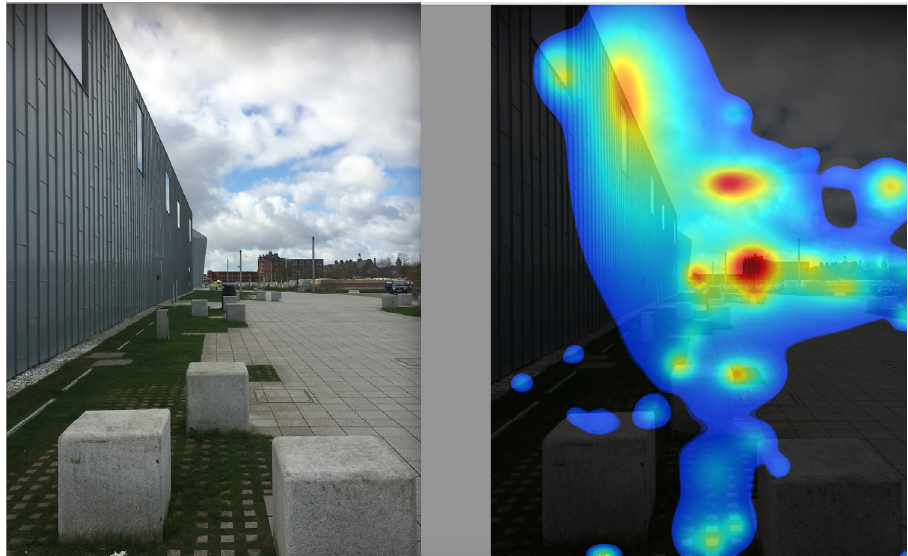
Figure 14. RSM side wall with concrete bollards/seats, and plaza. (Photo by A. Salama; VAS heatmap scan by N.A. Salingaros)